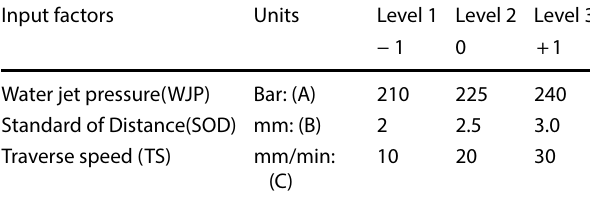
C) powder particles 4